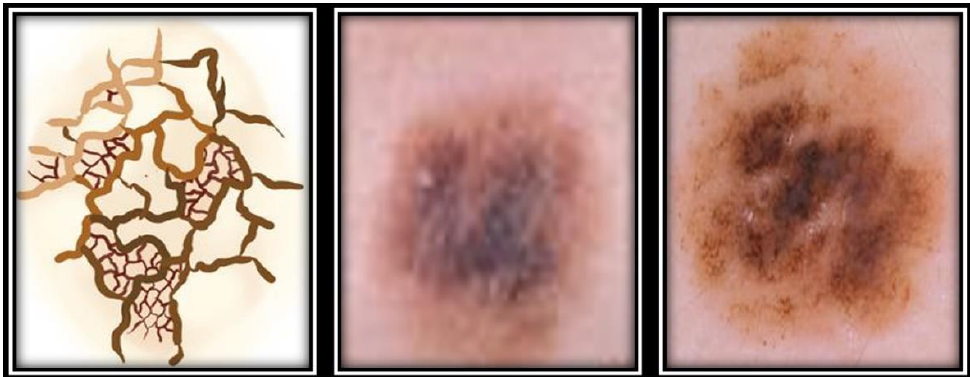
Figure 2. The t ypical pigmented network.